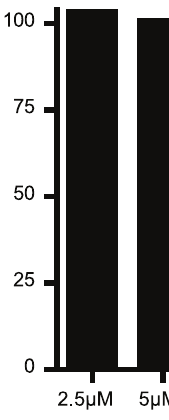
Figure 3. OK432 induced IL-12p70 production is TRIF depen- dent. Pre-treating the DC for 30 minutes at 37 u C with an inhibitory peptide of TRIF signaling reduced the level of OK432 induced IL-12p70 production in a dose dependent manner compared to a control peptide and OK432. Concentrations higher than 20 m M had a toxic effect on the DC. Data from one representative donor is shown.